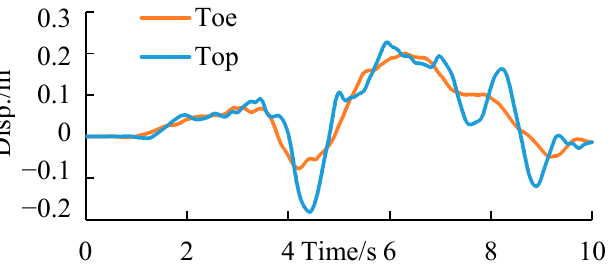
Figure 17. Displacement time–history curves of the monitoring point of the fill subgrade.